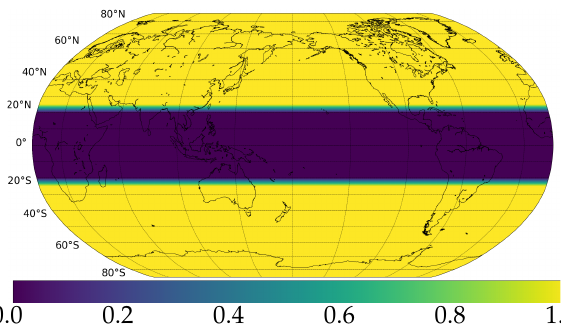
Figure 4. β coefficient from Equation (1b) indicating that initial sea-surface temperature (SST) is taken from the ocean analysis in the tropics (from 20 ◦ S to 20 ◦ N) and from Operational Sea Surface Temperature and Sea Ice Analysis (OSTIA) in the extratropics. The 5 ◦ transition regions can be seen as the bands consisting of intermediate